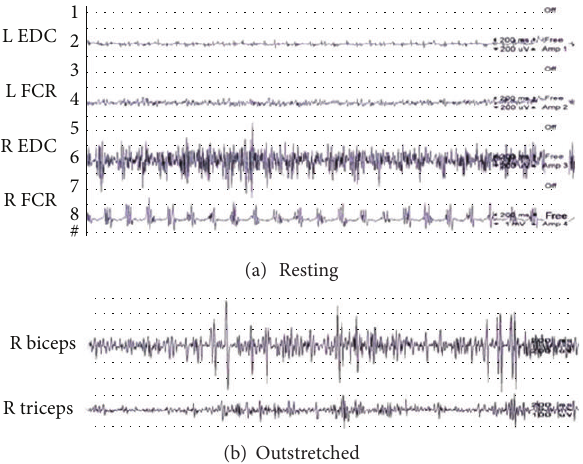
Figure 2: (a) Surface electromyography recording on a distal part of the arm at rest showed alternating rhythmic bursts at a frequency of 5-6 Hz. (b) Surface electromyography recording on a proximal part of the arm during outstretching showed short-duration, large amplitude arrhythmic bursts, mostly due to synchronous